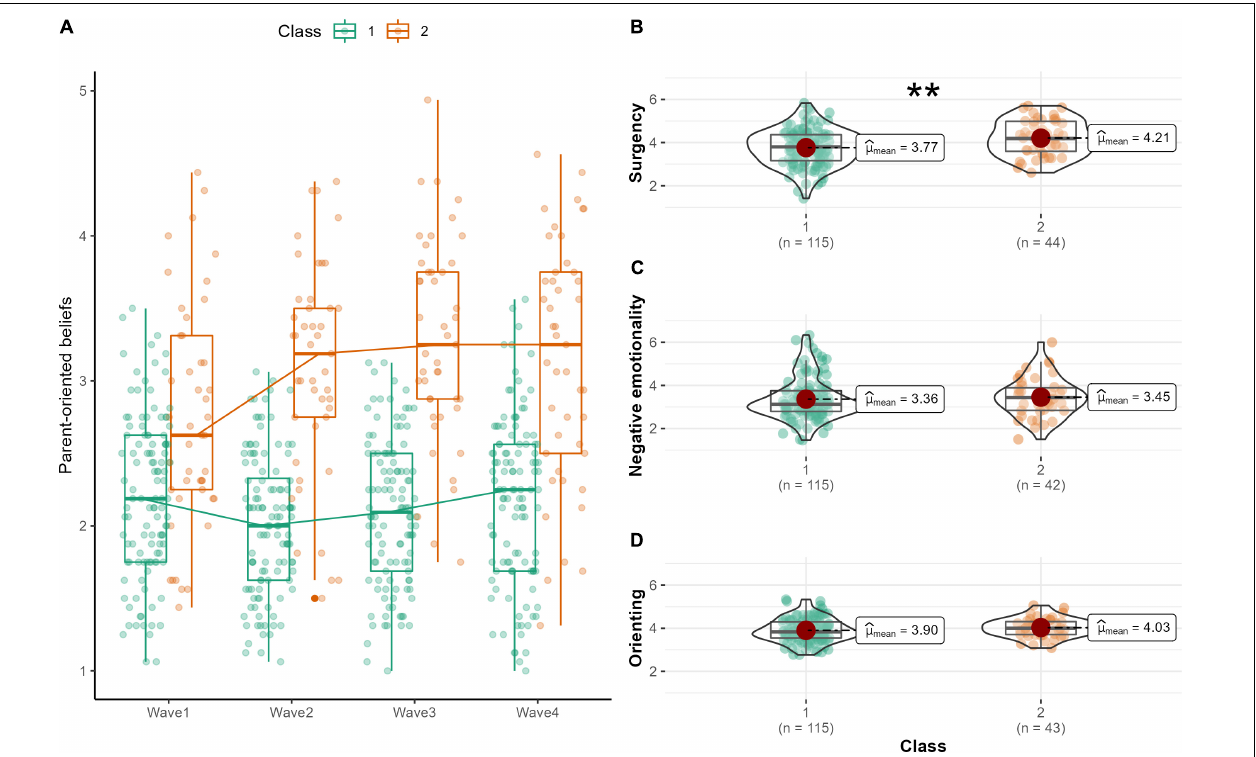
FIGURE 1 | (A) Two-class growth mixture modeling for parent-oriented beliefs. (B) Difference in surgency scores between the two classes. (C) Difference in negative emotionality scores between the two classes. (D) Difference in orienting scores between the two classes. ** p <